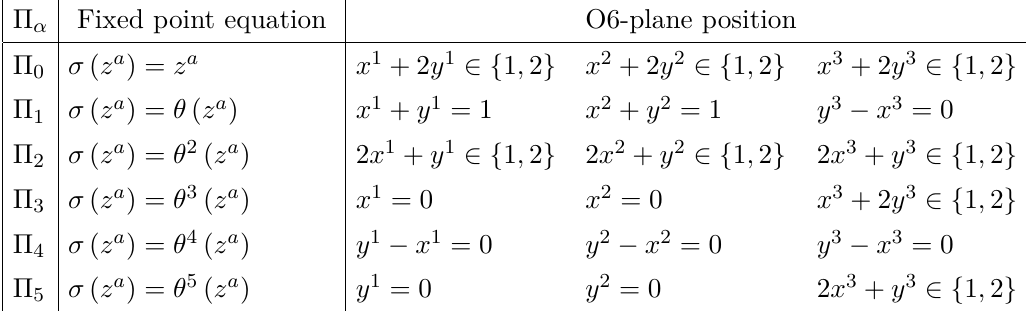
Table 4. O6-planes in T 6 / Z 6